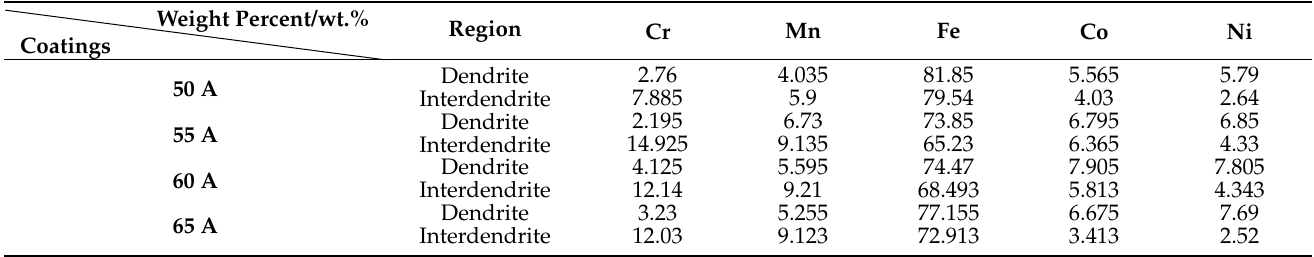
Table 3. Point analysis of elements in the middle part of the CoCrFeNiMn HEA coatings prepared at different plasma arc currents. Weight Percent/wt.%